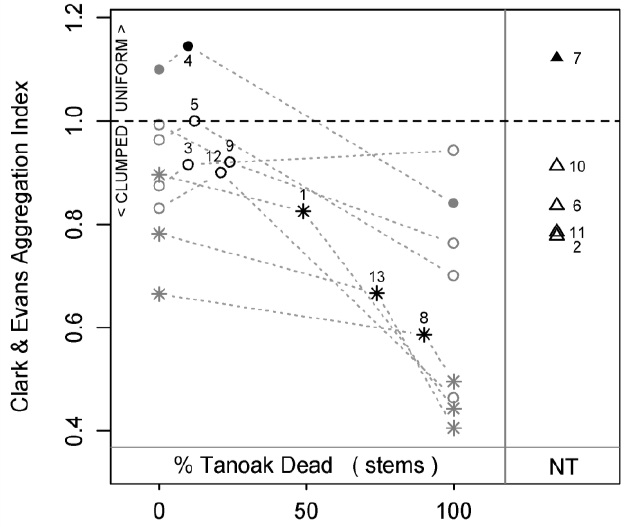
Figure 6. Clark & Evans aggregation index as a function of plot status and disease progression. Lower index values indicate a greater degree of clustering. Black numbered symbols represent present conditions of all 13 sampled plots: circles = healthy plots (H); stars = diseased plots (D), triangles = plots without tanoak (NT); open symbols = second growth plots; closed symbols = old growth plots. Grey symbols represent reconstructed pre-SOD conditions (0% tanoak dead) and projected future conditions (100% tanoak dead) for all plots with tanoak. Grey dotted lines connect each plot’s present condition to its respective pre-SOD and future conditions, thereby displaying predicted transitions for each plot. Plot ID numbers correspond to Table